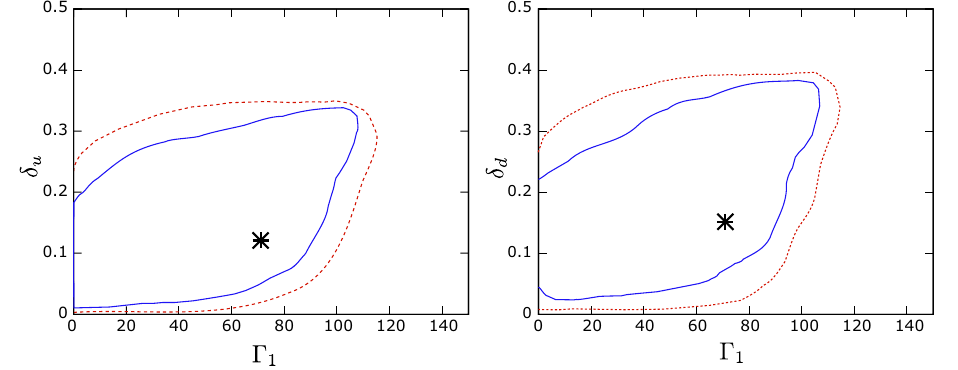
Fig. 1 Allowed regions in the parameter space at 70% CL (blue line) and 95% CL (red dashed line). Here, the black asterisk corresponds to the BFP, while the (cid:16) , (cid:21) μ u , and (cid:21) μ d parameters are fixed to the values given in the first row of Table 1